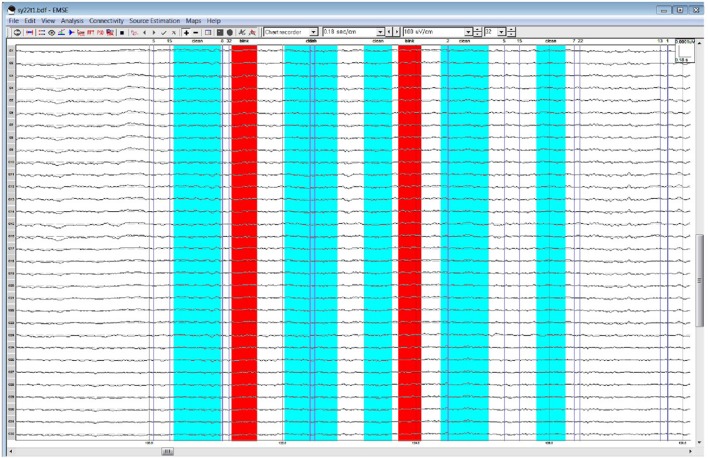
Processor B's selection of clean data (cyan) and blinks (red)·within the frontal quadrant of the brain between 119 and 128 ms.